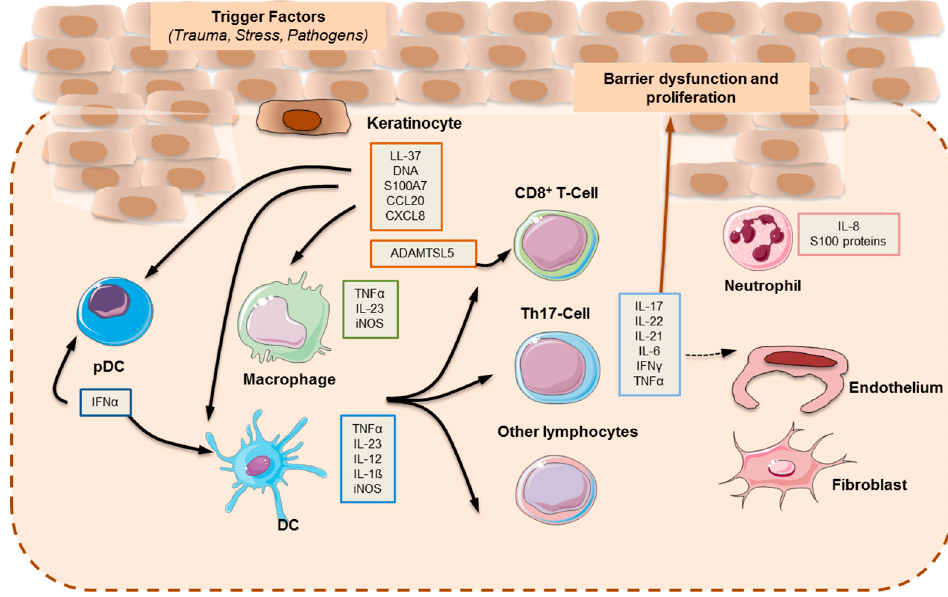
Figure 5. The pathogenesis of psoriasis.